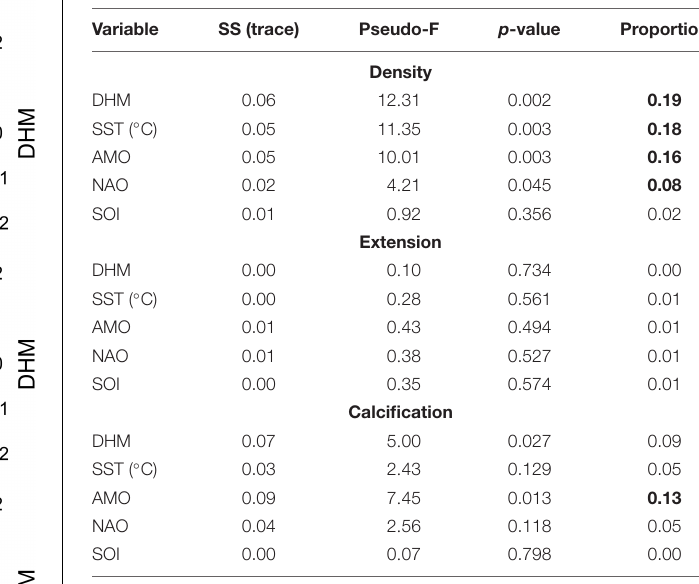
TABLE 3 | DISTLM marginal test for the period 1963–2015.